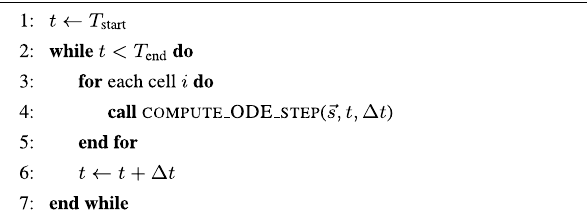
Algorithm 1. Simple skeleton for the simulation scenario (outer loop over